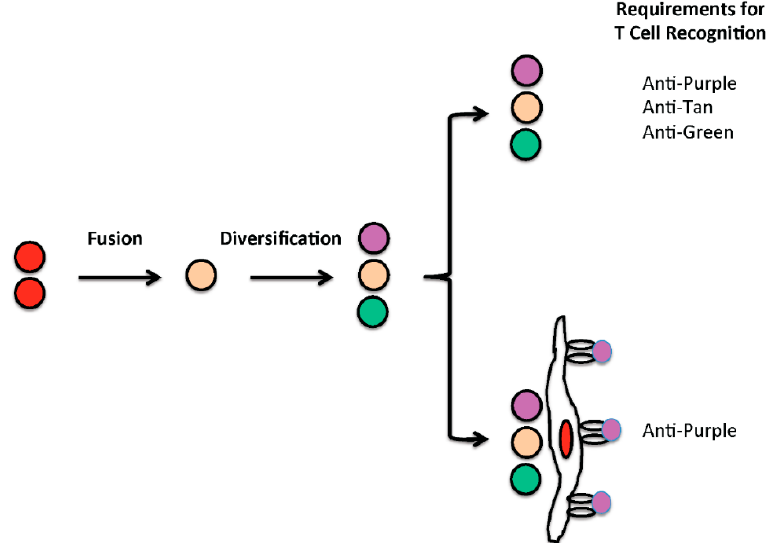
Figure 2. Impact of cell fusion on tumor immune surveillance mediated by T cells. Cell fusion potentially causes genomic diversification, modeled by conversion of red cells with red protein to cells with purple, tan or green proteins. An individual is tolerant to the native, red protein, but the immune system, i.e., the T cell repertoire, potentially recognizes purple, tan or green variants. In principle, diversification can spark immunity to some variants. However, extensive diversification, as modeled at the top, might allow tumor cells to escape immune control unless all variants are recognized. On the other hand, where tumor protein variants are taken up and presented by endothelial cells, as modeled below, recognition of one or a few highly expressed variants might suffice to support T cell mediated control of tumor growth. In this later case T cell interaction with capillaries activates or destroys endothelium causing tumor cells to be circumscribed or killed.